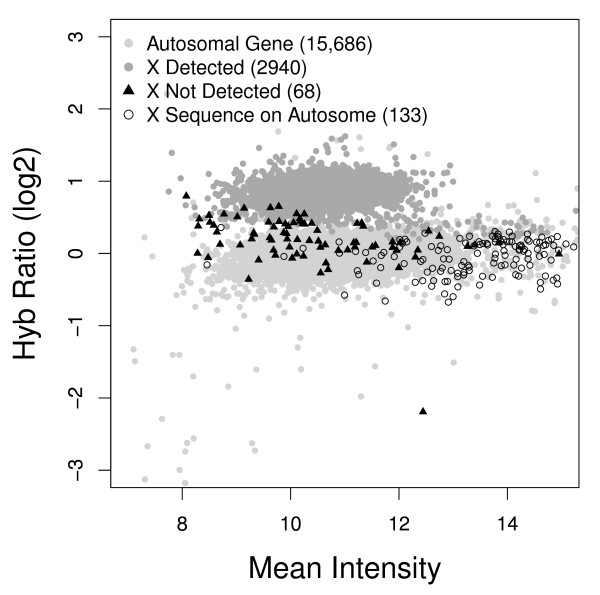
Plot of D. melanogaster female vs. male genomic DNA. X chromosome features identified as being in genomic excess in the female sample ("X Detected") and not identified as being in genomic excess ("X not Detected"), and the autosomal features identified as being in genomic excess that also share sequence similarity to an X chromosome sequence ("X Sequence on Autosome").